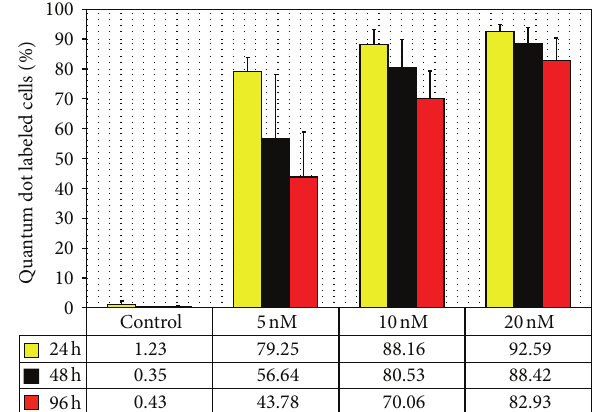
Figure 4: Quantitative analysis of QD labeled cells measured by FACS analysis. The amount of QD labeled cells was estimated for three label concentrations (5nM, 10nM, and 20 nM) and for three time points (24 h, 48h, and 96 h) ( 𝑛 = 2 ). Total count 10.000